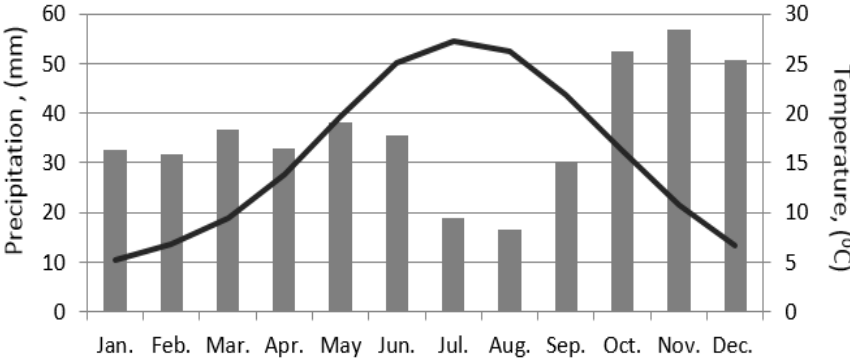
Figure 2. Mean monthly temperature and rainfall during the period 2013 to 2015 in the study area.